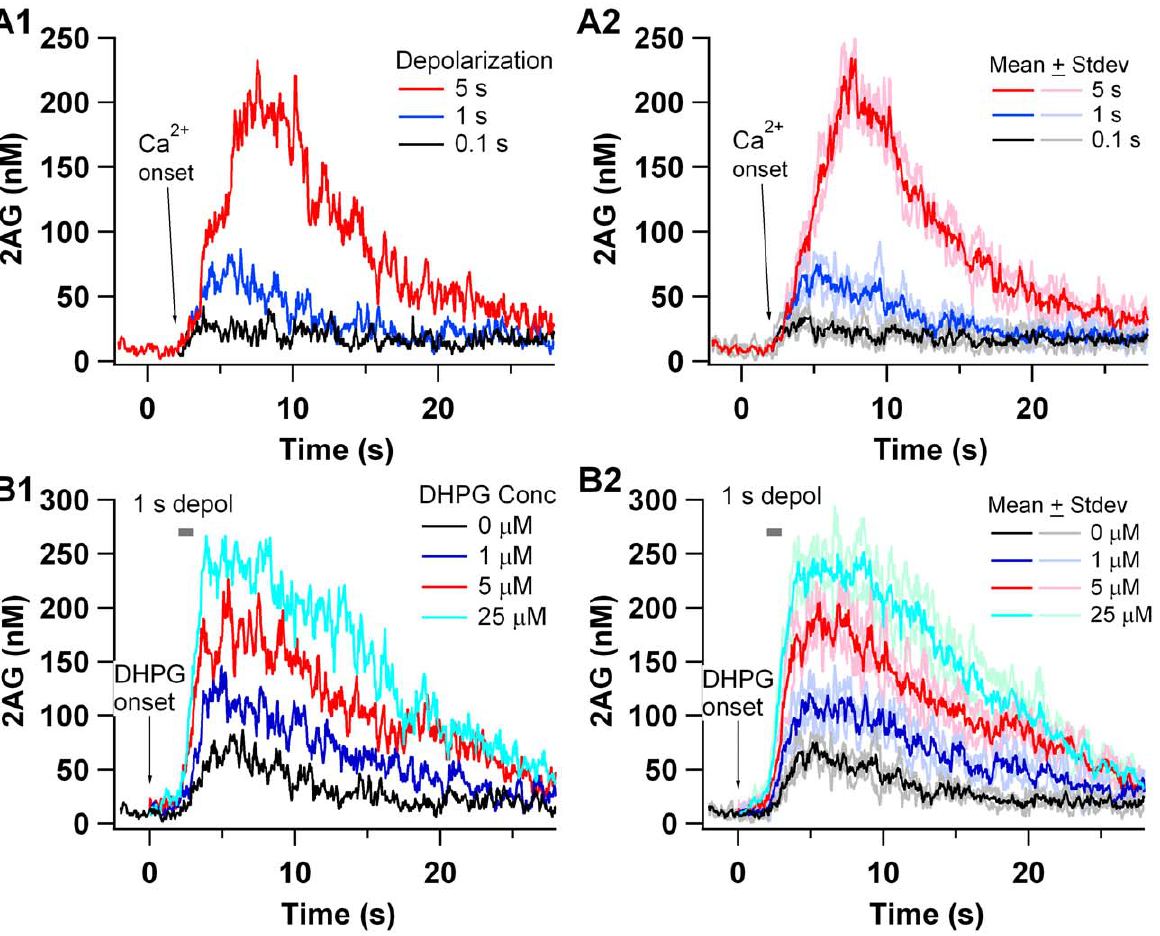
Figure 2. 2AG in response to depolarization is facilitated by mGluR activation. (A) 2AG in response to depolarization (calcium influx) alone. 2AG increases with duration of calcium influx, but minimal 2AG is detectable with a 0.1 sec depolarization. (B) 2AG in response to depolarization together with mGluR stimulation. DHPG is applied at 0 sec and depolarization starts at 2 sec. Increased mGluR stimulation increases quantity of 2AG production. A1 and B1 show results of a single trial, while A2 and B2 show the average and standard deviation of 3 independent trials (random